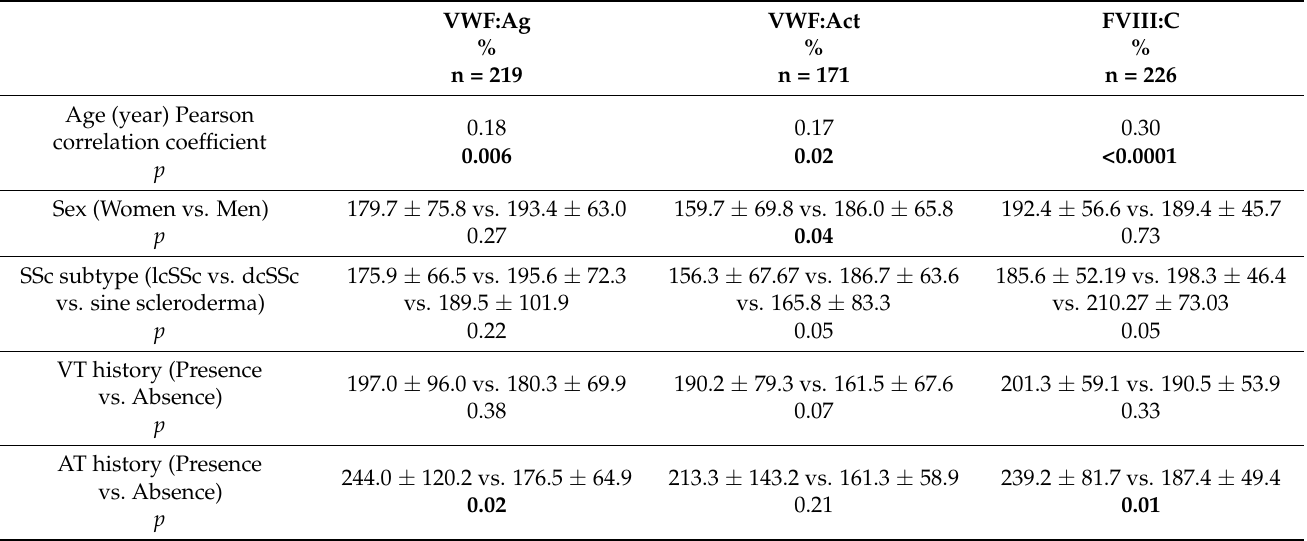
Table 4. Associations between hemostasis and endothelial activation parameters and SSc